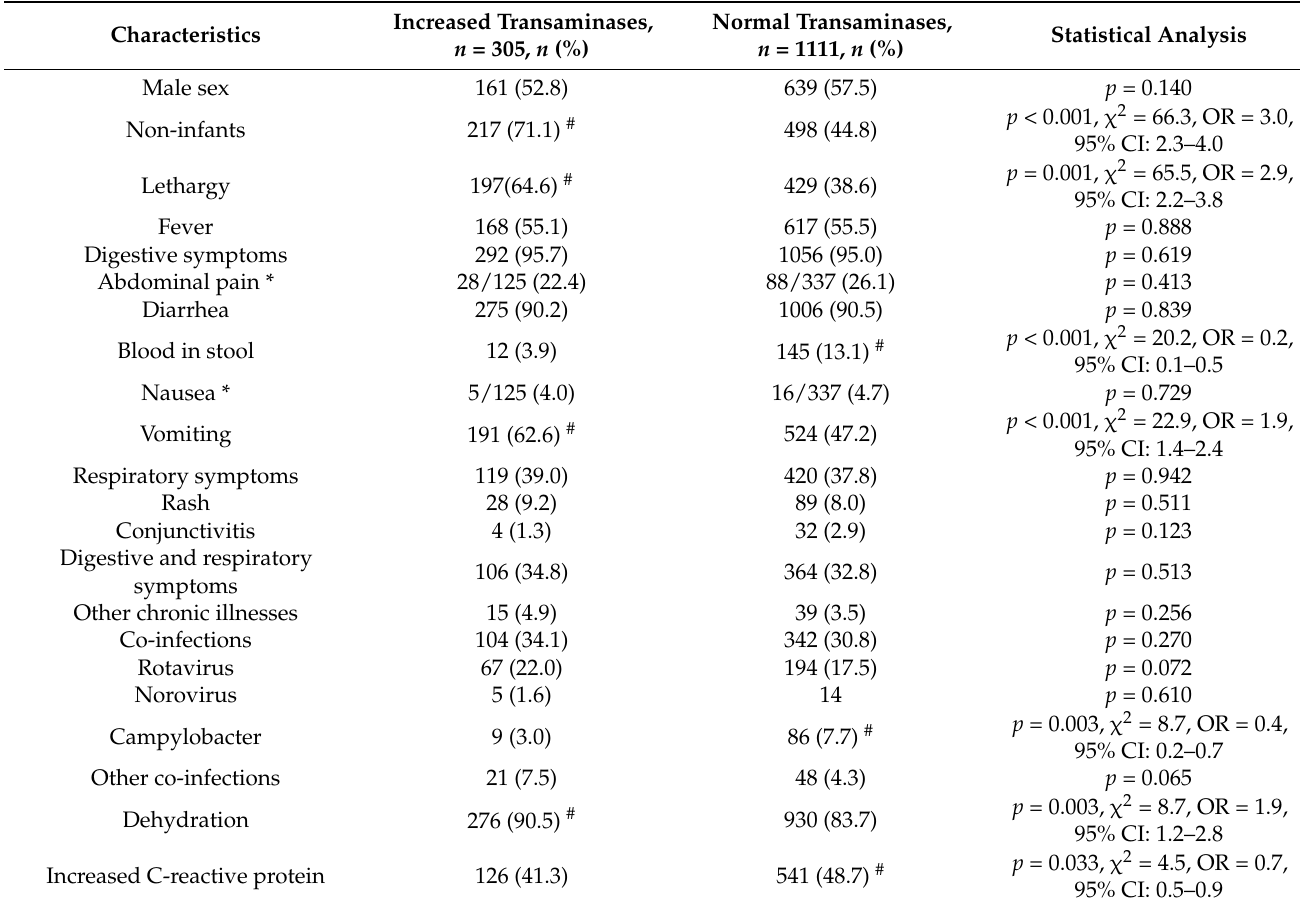
Table 2. Predictors of increased liver enzymes.